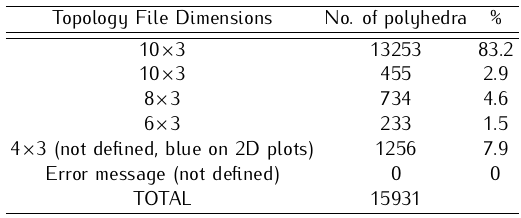
Table 1. Polyhedral modeling results of soft sediments.